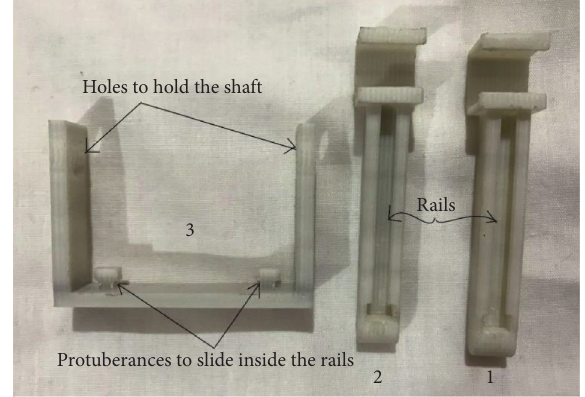
Figure 9: St-PLA prototype of the geometrical tool